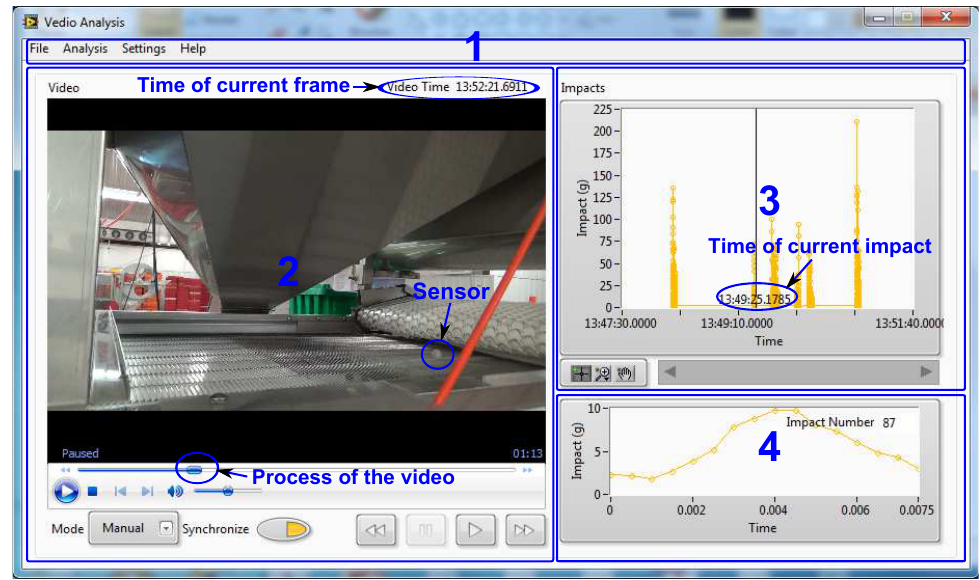
Figure 7. Front panel of the video analysis sub-program. 1, Menu bar; 2, video display and control; 3, overall impacts display; 4, single impact display. The video and impact data come from a field test on a blueberry packing line. It clearly shows that the impacts near the cursor occurred when the sensor was transferred from the white conveyor belt to the steel conveyor belt. The program uses relative time to synchronize the display between the video and impacts, and even their absolute time is